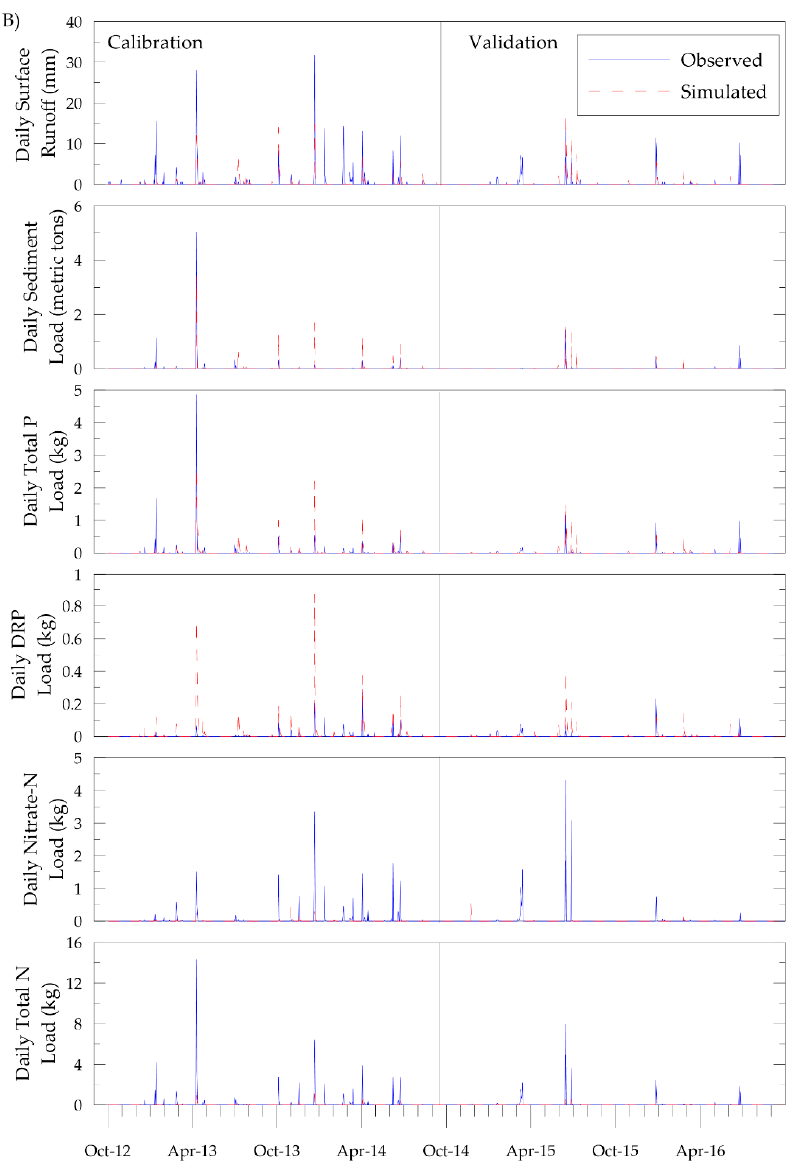
Figure 5. Comparison of ( A ) monthly and ( B ) daily simulated and observed streamflow,